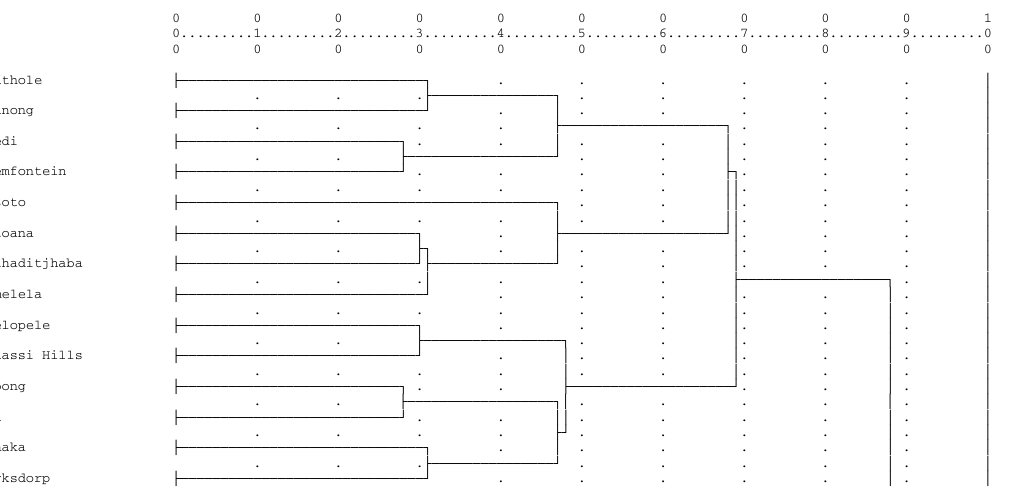
Figure 5: Dendogram of the last 14 regions in the Central region Figure 5: Dendrogram of the last fourteen regions in the Central region. In Figure 6, the regions of Kai !Garib (Augrabies, Kakamas and other regions in the Northern Cape) and !Kheis (Groblershoop, Grootdrink and more in the Northern Cape) merged with the Kimberley, Letsemeng (Petrusburg, Jacobsdal and more in the Free State) and Vryburg (also Schweizer-Reneke and other regions in the North West Province)regions (47% intrazonal). This region merges with the Rustenburg ( ) Mafikeng ( ) fusion (69% intrazonal), resulting in the ‘Sixth Province’ in The Modderfontein region merges with the Boksburg, Johannesburg fusion (28% intrazonal), and the Evaton (Vaal Triangle, including Sasolburg in the Free State) figure 8. and Lesedi (Heidelberg, Nigel Springs) regions then fuse into the Johannesburg region (46% intrazonal), then follow the Pretoria region, the Randfontein region and Province’ of the nine last clusters shown in Figure 8. lastly the Merafong (Carltonville, Khutsong and others) region. (66% intrazonal). This results in the ‘Seventh Province’ in Figure 8.